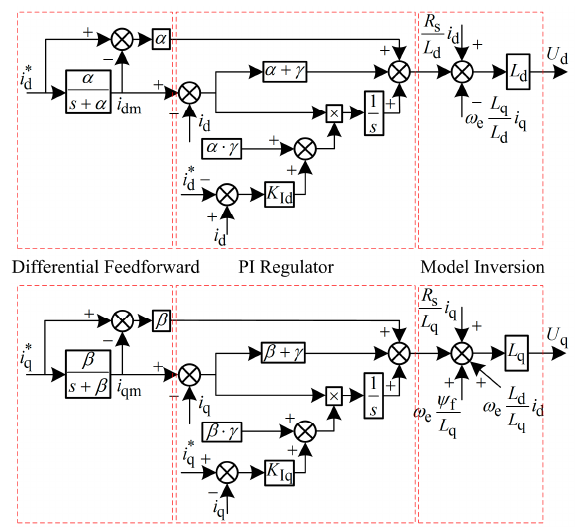
Figure 3. The improved UDE-based control with parameter tuning.